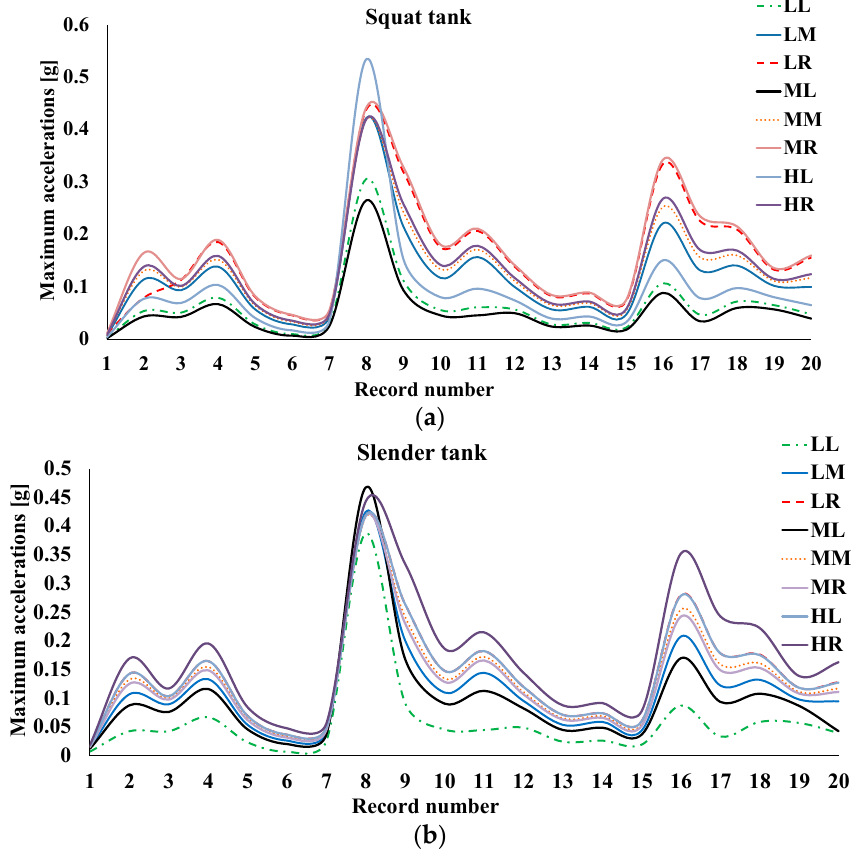
Figure 10. Accelerations at the tank base for: ( a ) the squat and ( b ) slender geometry.